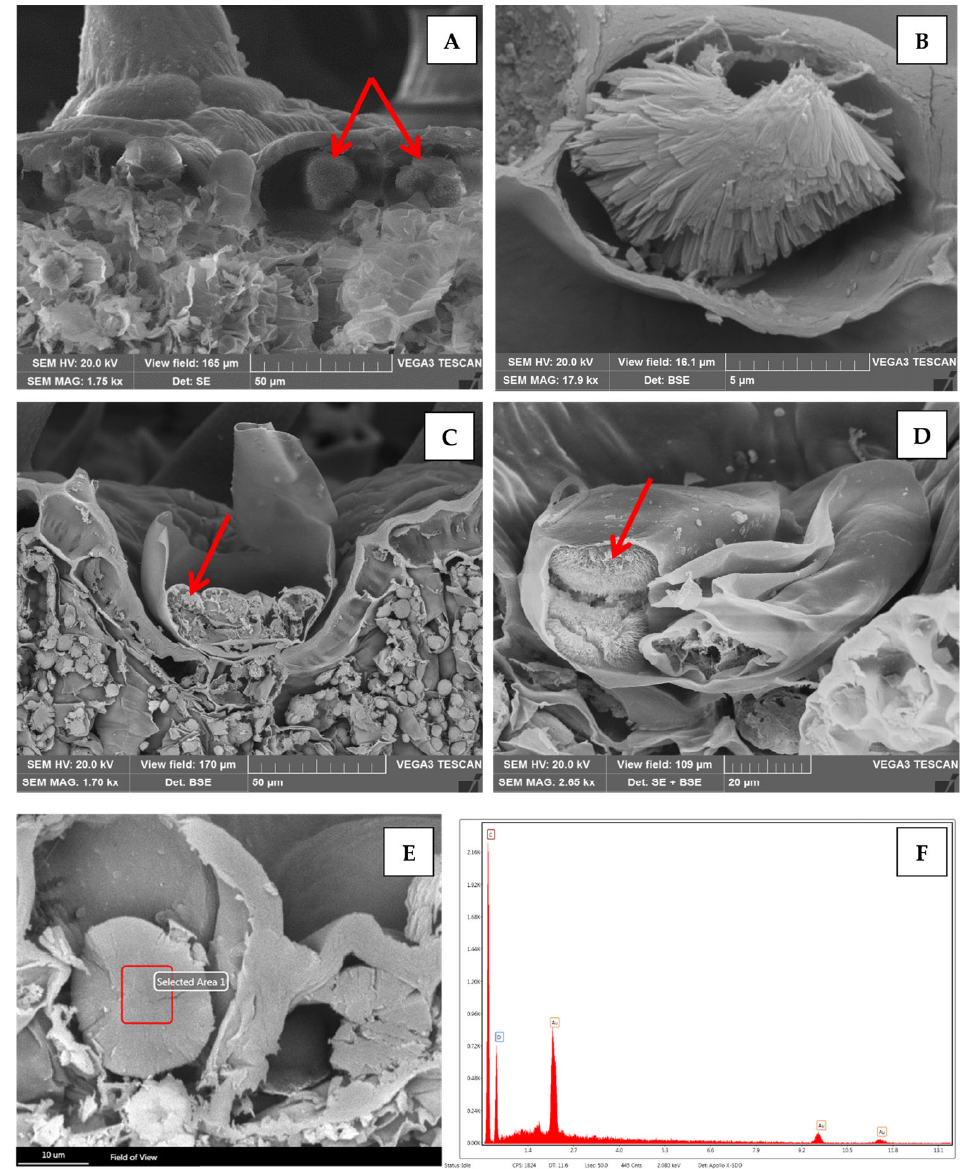
Figure 3 . Transversal section of leaf analyzed by SEM ( A – D ) and SEM ‐ EDX ( E , F ). Diosmin spherocrystal aggregates are visible within epidermal cells (( A ) red arrows); a more detailed morphological characterization of a spherocrystal within a single epidermal cell is shown at higher magnification ( B ). Diosmin spherocrystals were also present in the secretory cells of the peltate glandular trichomes (( C , D ) red arrow). SEM ‐ EDX analysis confirmed the absence of mineral elements in the crystal composition ( E , F ).